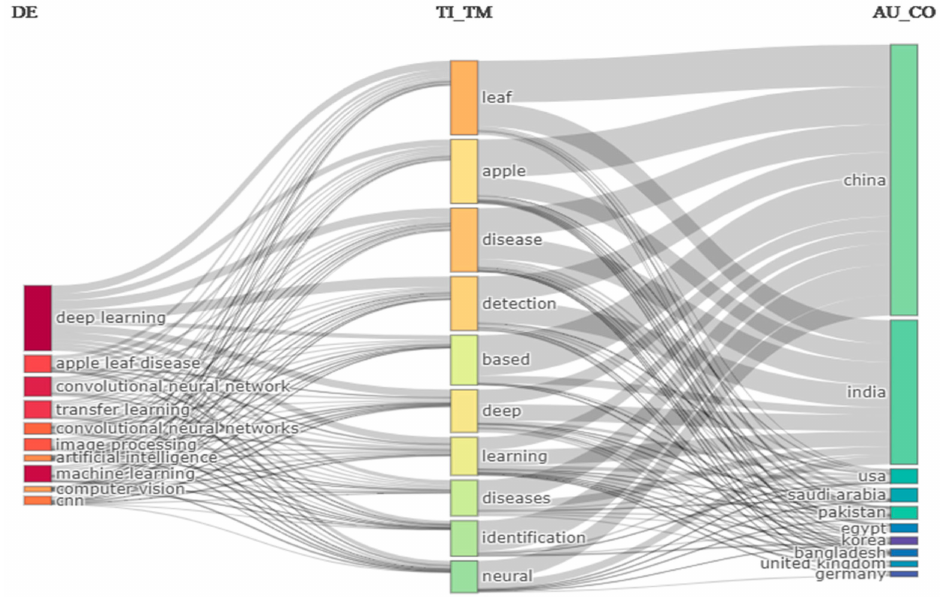
Figure 14. Three Field Plot (Sankey Diagram) of Country, Keywords and References of cited references of publication for the ten most researched